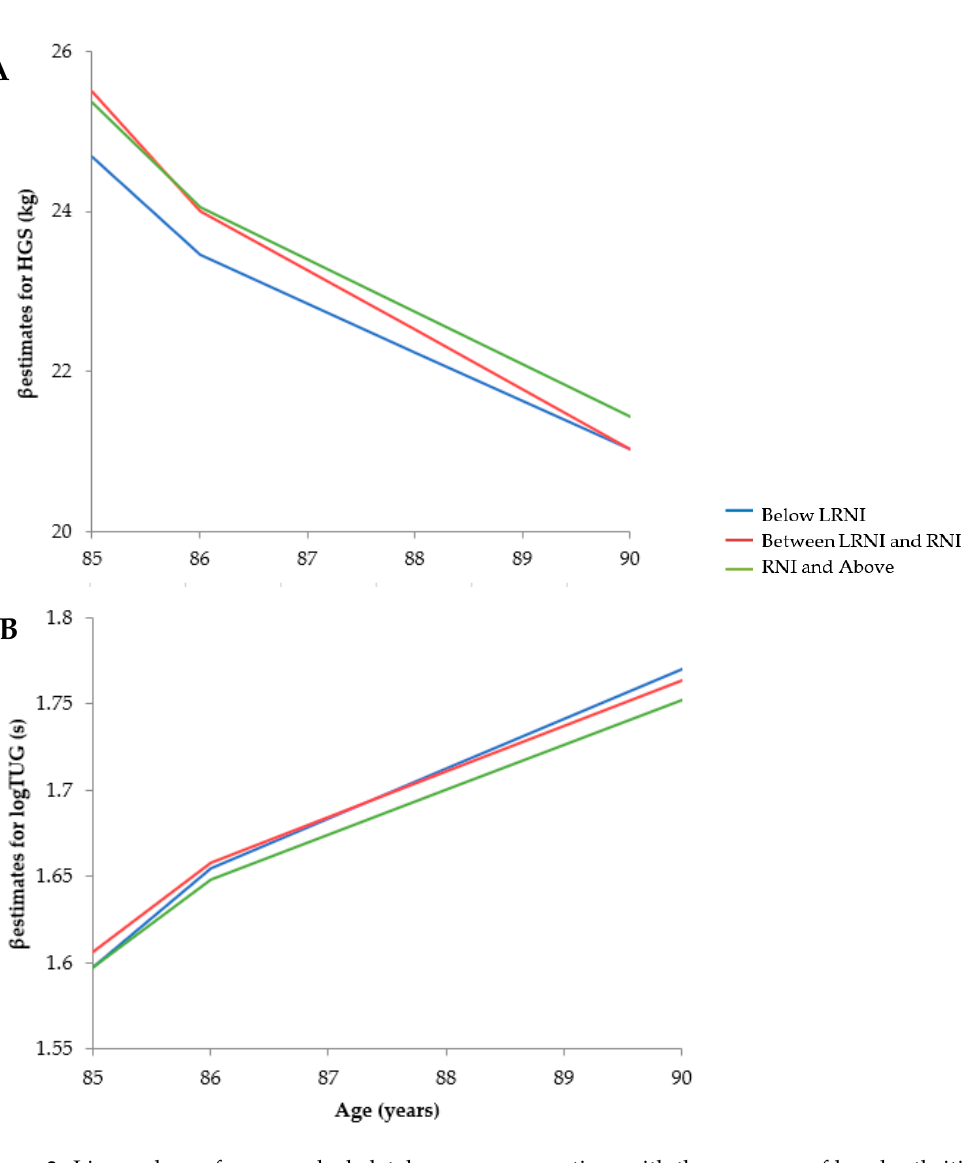
Figure 3. Linear slopes for musculoskeletal measures over time with the presence of hand arthritis (hand grip strength, HGS, A ) or the use of walking aids (timed-up-and-go, TUG, B ) as predictors in addition to age at baseline, sex, National Statistics Socio-Economic Classification (NS-SEC), self-rated health, energy intake, protein intake, medication use, body mass index (BMI), fat-free mass, physical activity, cognitive impairment, disability score, misreporters and change in diet. Time intervals between each measurement were not consistent: 0, 1.5, 3 and 5